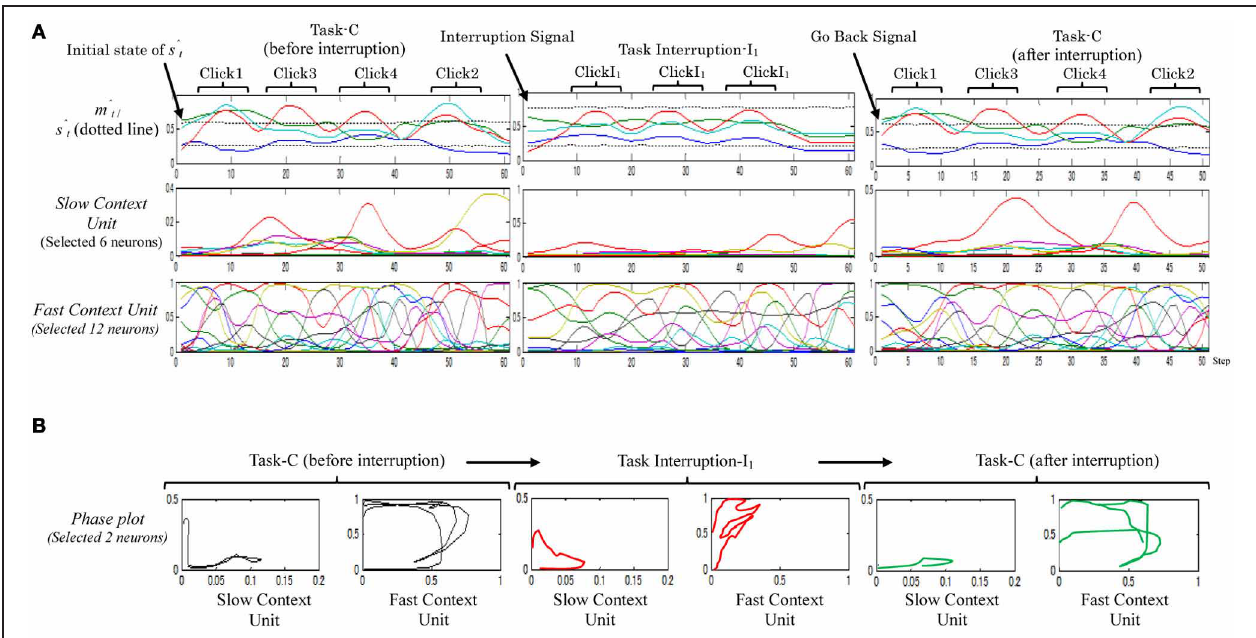
plots illustrate the task interruption part; black plots illustrate the original task before the task interruption; and green plots illustrate the original task after task interruption I 1 .